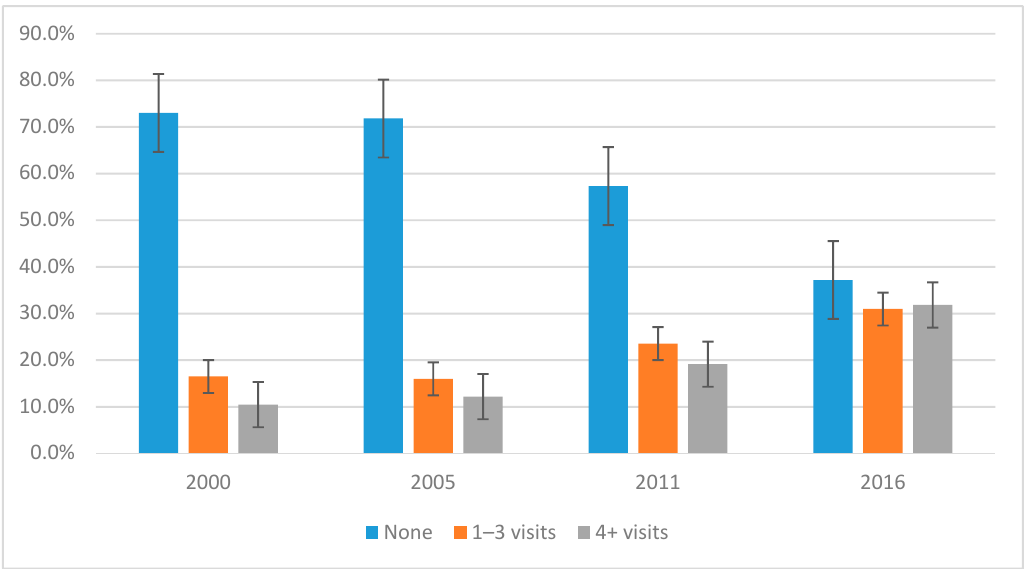
Figure 2. Trends in antenatal care service use in Ethiopia, 2000–2016.